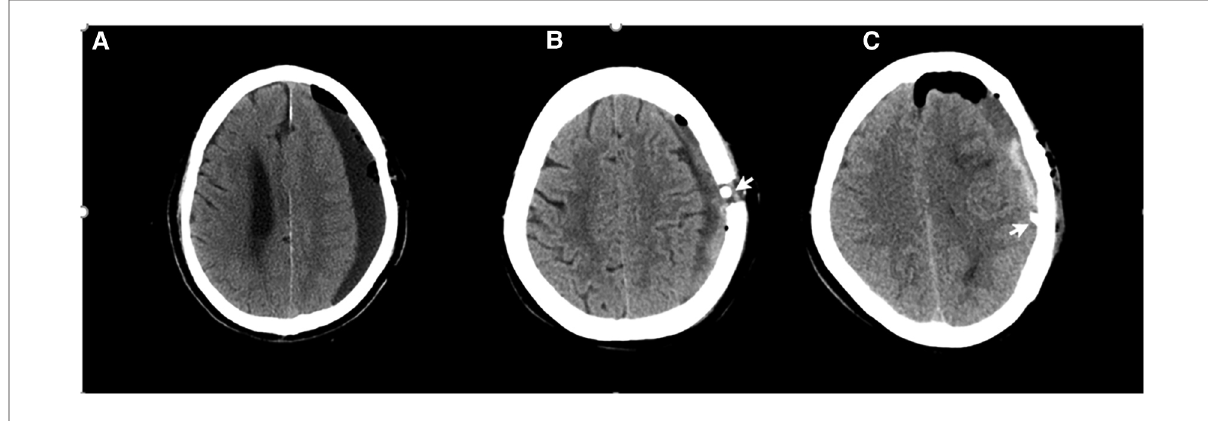
FIGURE 2 The classi fi cation of residual hematoma. The arrowhead points to the drain tube. ( A ) Postoperative hypo-density type, ( B ) postoperative hybrid- density, and ( C ) postoperative high-density type (see the explanation in the